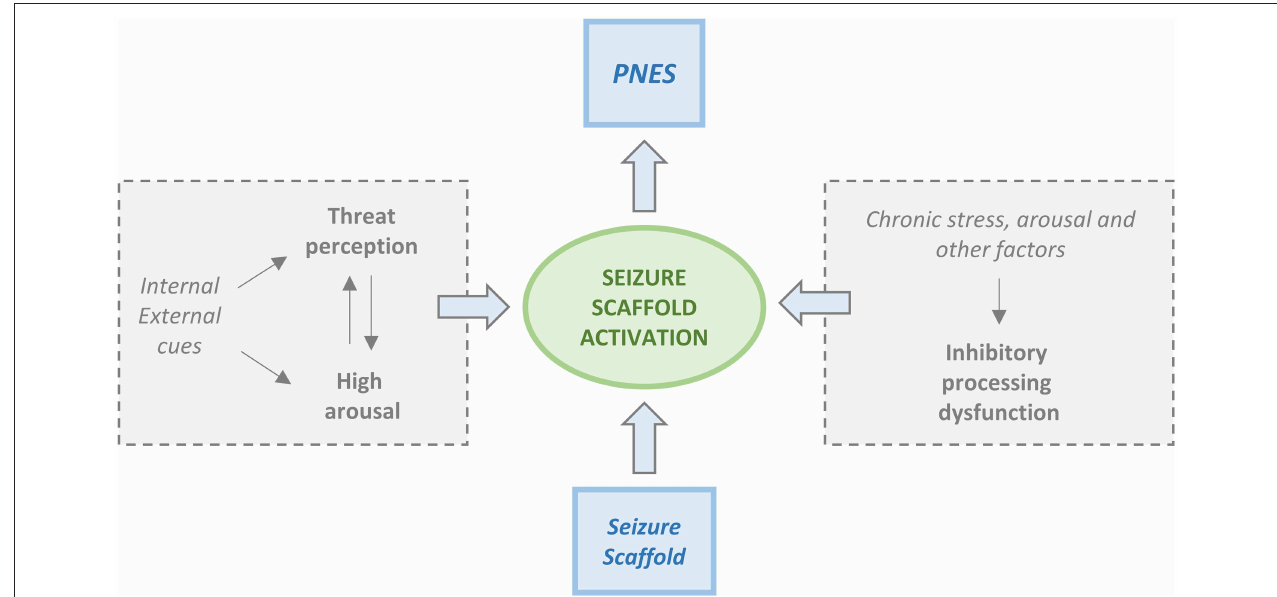
FIGURE 1 | Simplified scheme of the Integrated Cognitive Model (ICM). PNES result from the automatic execution of acquired mental representations of seizures (i.e., the enacting of a “seizure scaffold” ). The seizure scaffold consists of a sequence of perceptions and motor activities shaped by experiences such as inherent reflexes (i.e., freezing movements, startle, wandering) or physical symptoms (i.e., of pre-syncope, dissociation, hyperventilation, head injury). Seizure scaffolds can be triggered by a range of internal or external stimuli. The process often occurs in response to increases in autonomic arousal. However, the seizure scaffold is more likely to be